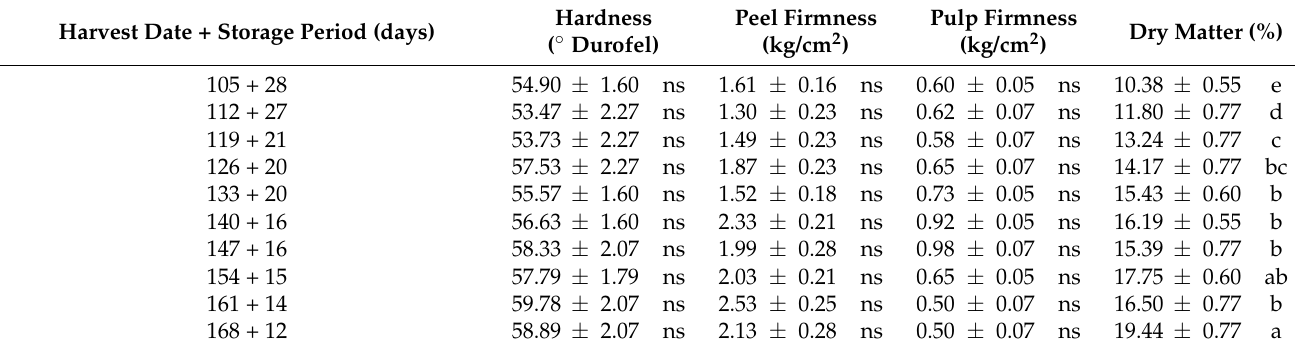
Table 2. Physicochemical parameters of Osteen mango (mean ± SD, n = 3) at consumption point after period of storage at 20 ◦ C and 70% RH (harvest date + shelf